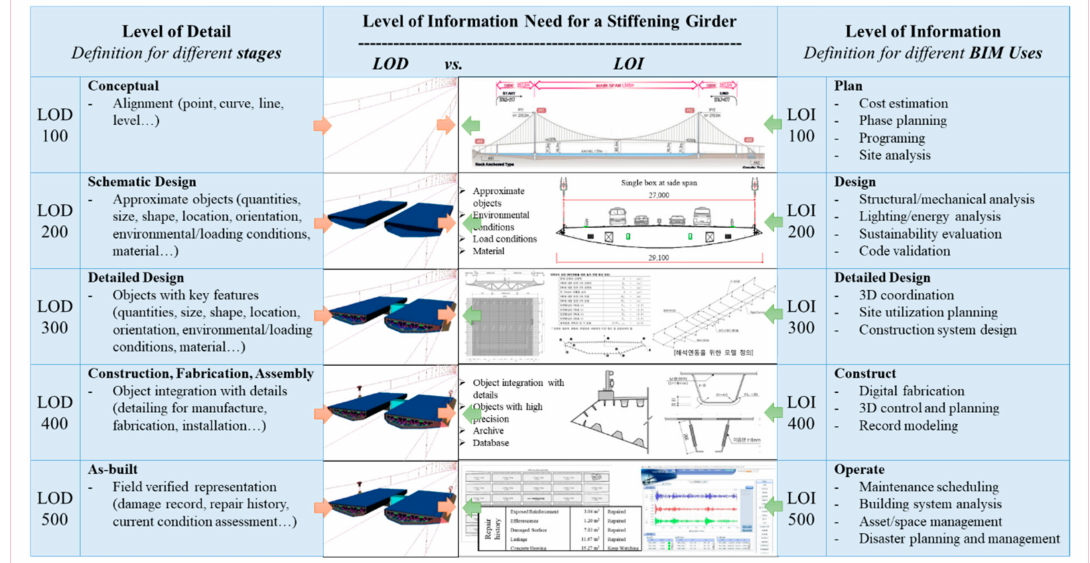
Figure 4. Level of development for a sti ff ening girder